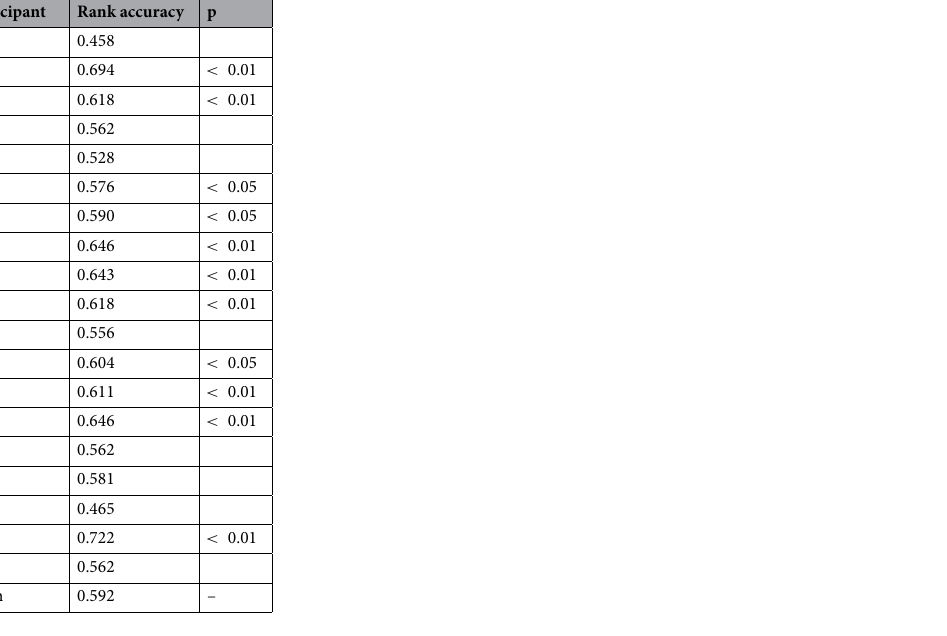
Table 3. Rank accuracies for identifying pieces of music played to participants in our EEG